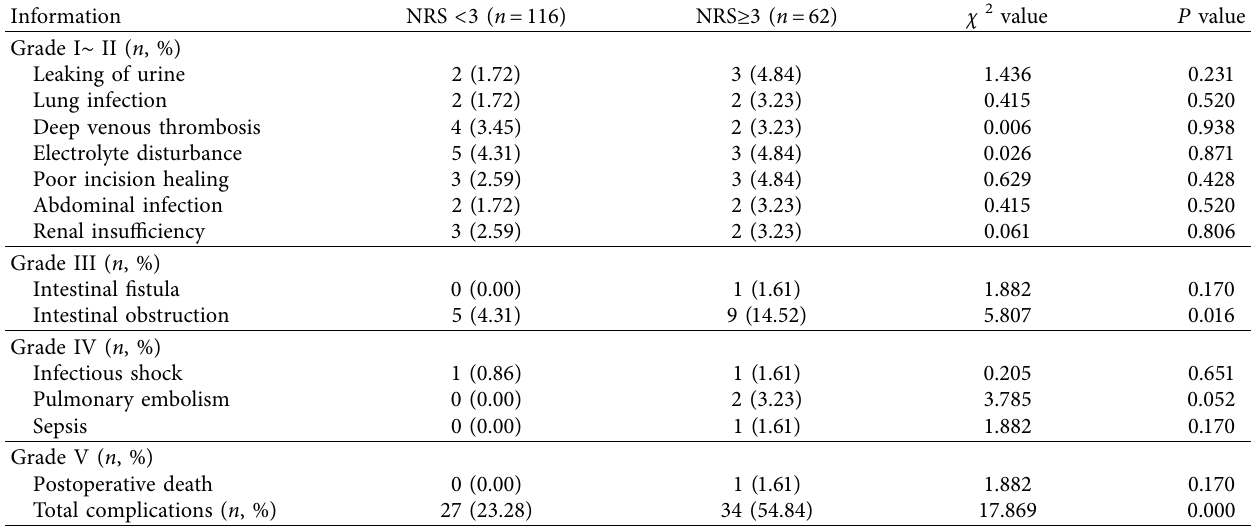
Table 4: Comparison of postoperative complications.